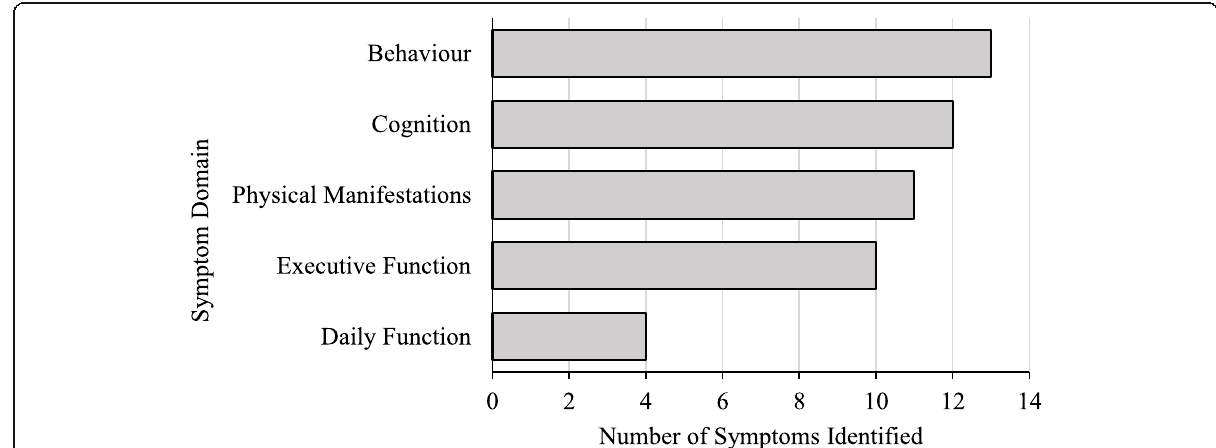
Fig. 1 Symptom domains identified as most important. The number of symptoms reported was plotted as a function of the specific symptom domain categories caregivers identified as most important in this study. Symptoms related to daily function were least often regarded as important by the